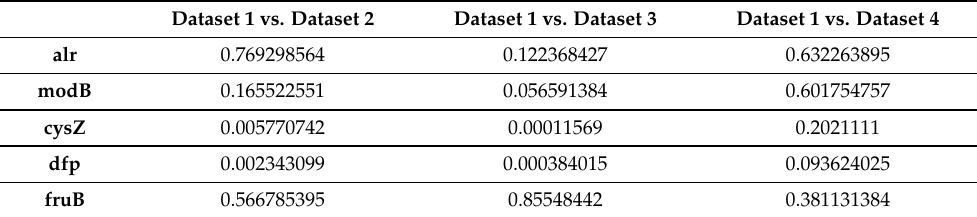
Table 2. Excerpt of the p -value matrix. Each column corresponds to a pairwise comparison between two datasets while each row contains the gene ID. For the sake of readability, only three columns and five rows are reported